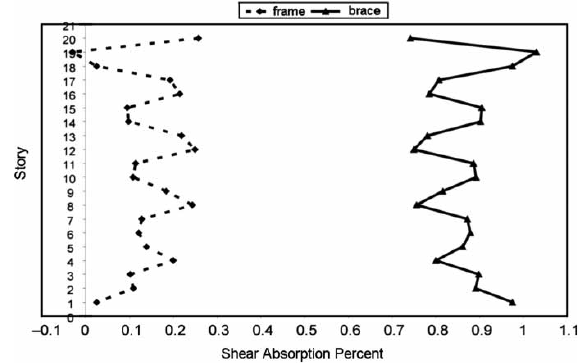
Fig. 18. Shear absorption percent of frame and brace systems in BFS20 model